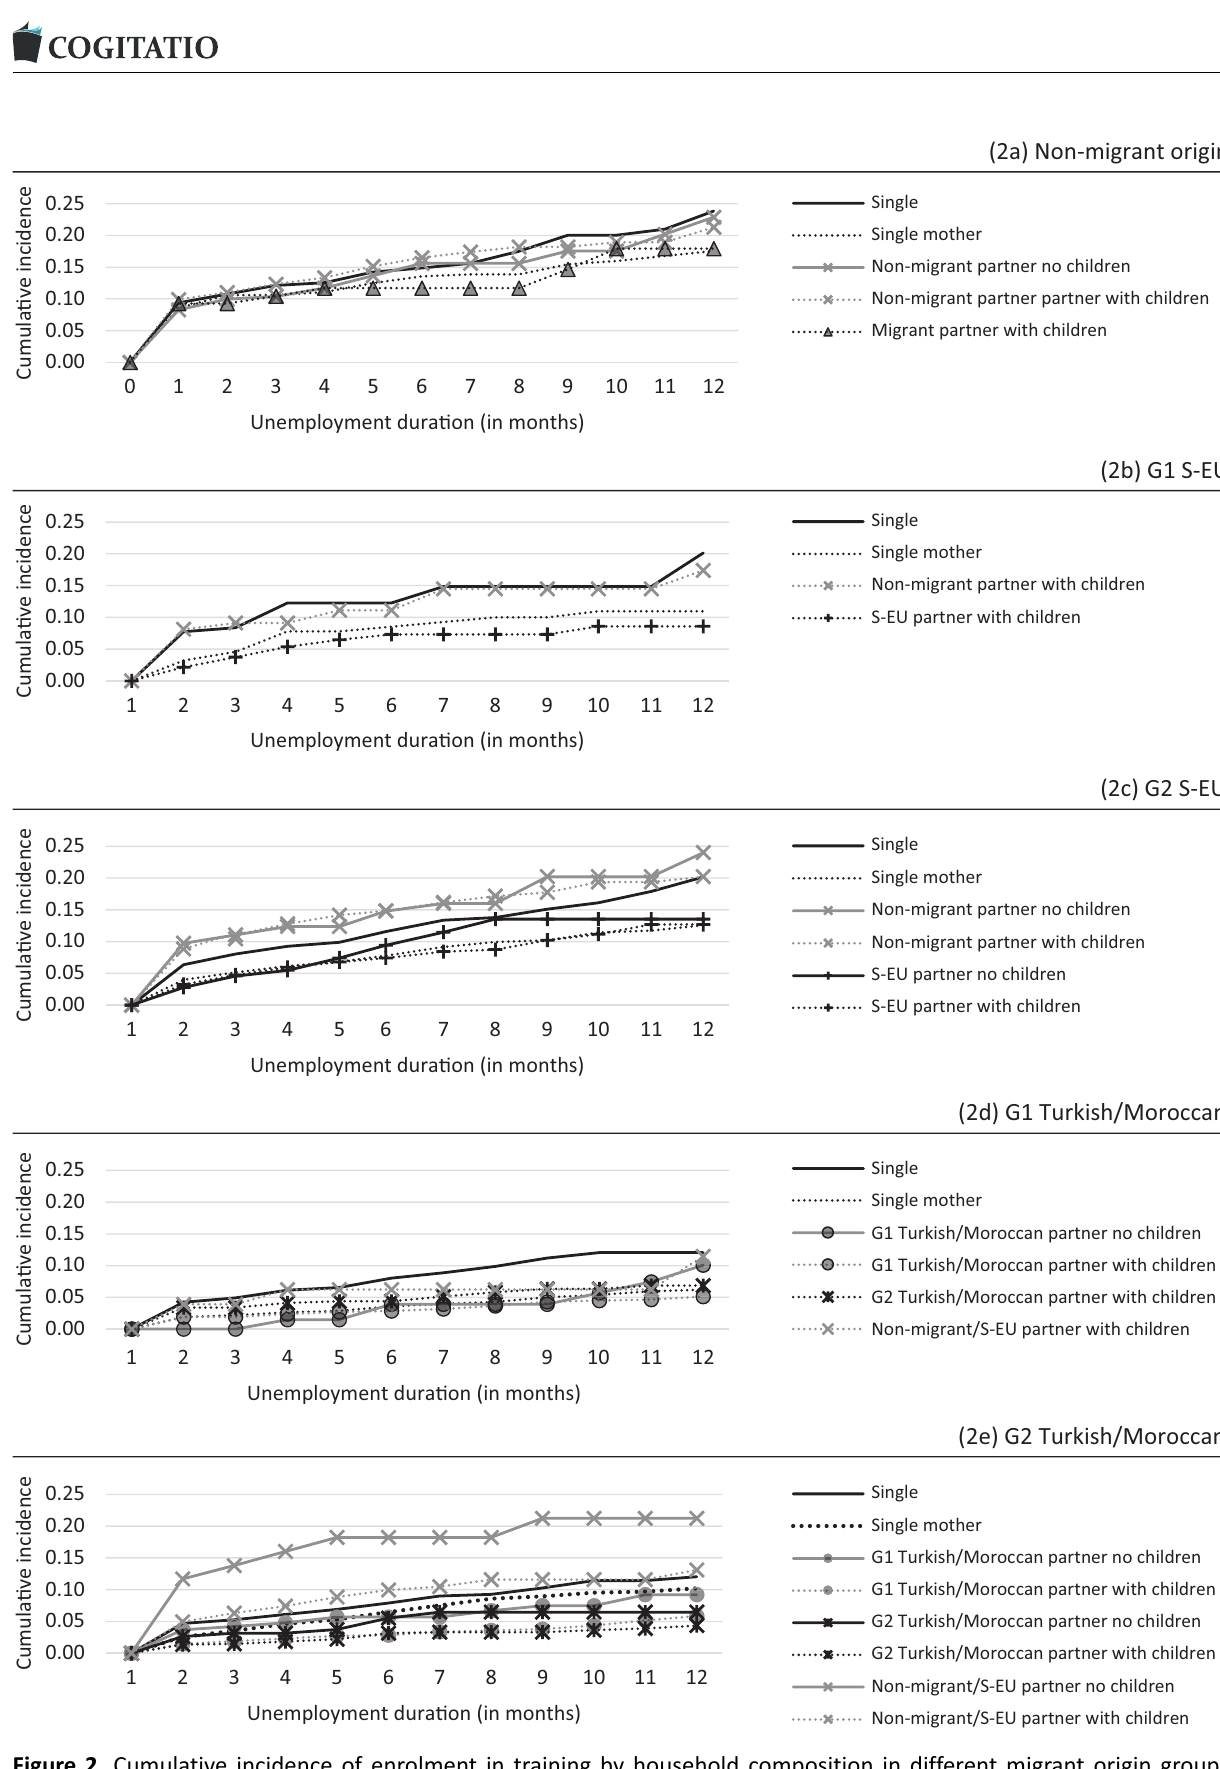
Figure 2. Cumulative incidence of enrolment in training by household composition in different migrant origin